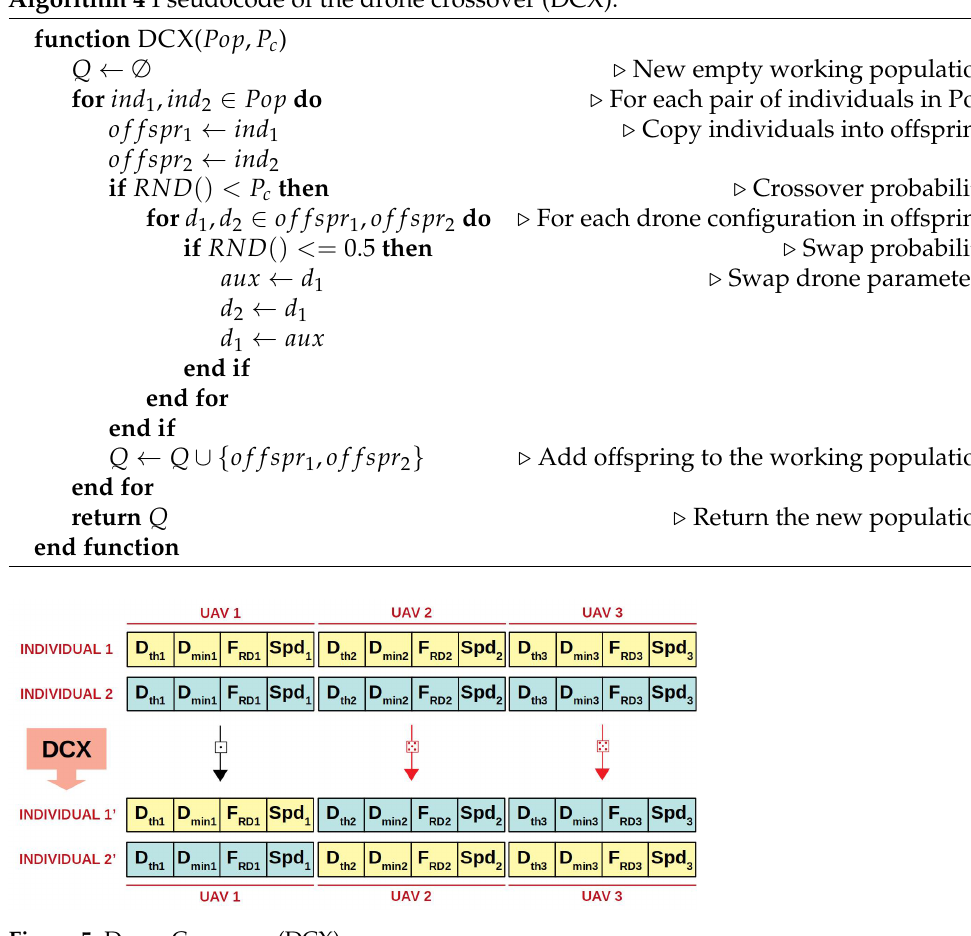
Figure 5. Drone Crossover